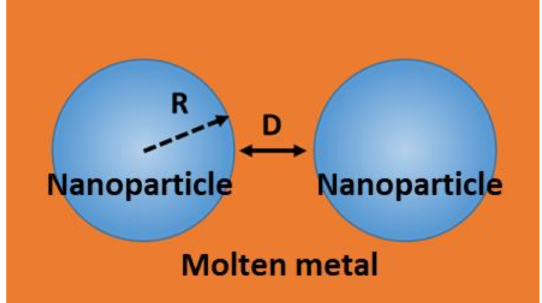
Figure 6. Model for two identical nanoparticles interacting in a molten